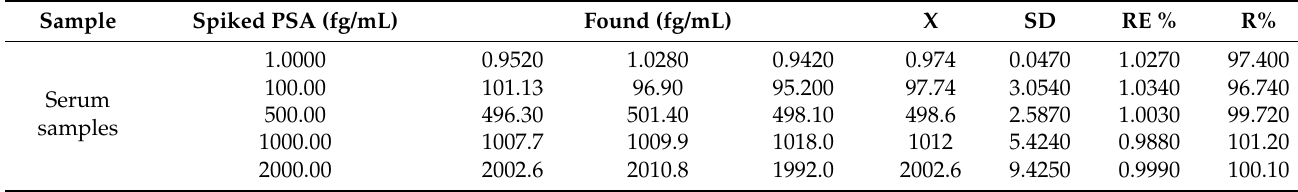
Table 3. PSA determination in real serum samples using Zn-MOFs-NP biosensor.